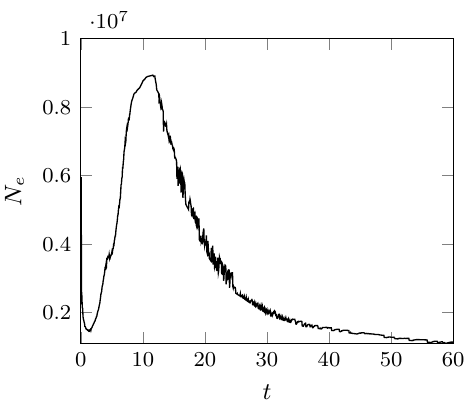
Figure 7. Number of elements in the three-dimensional simulation as a function of time.